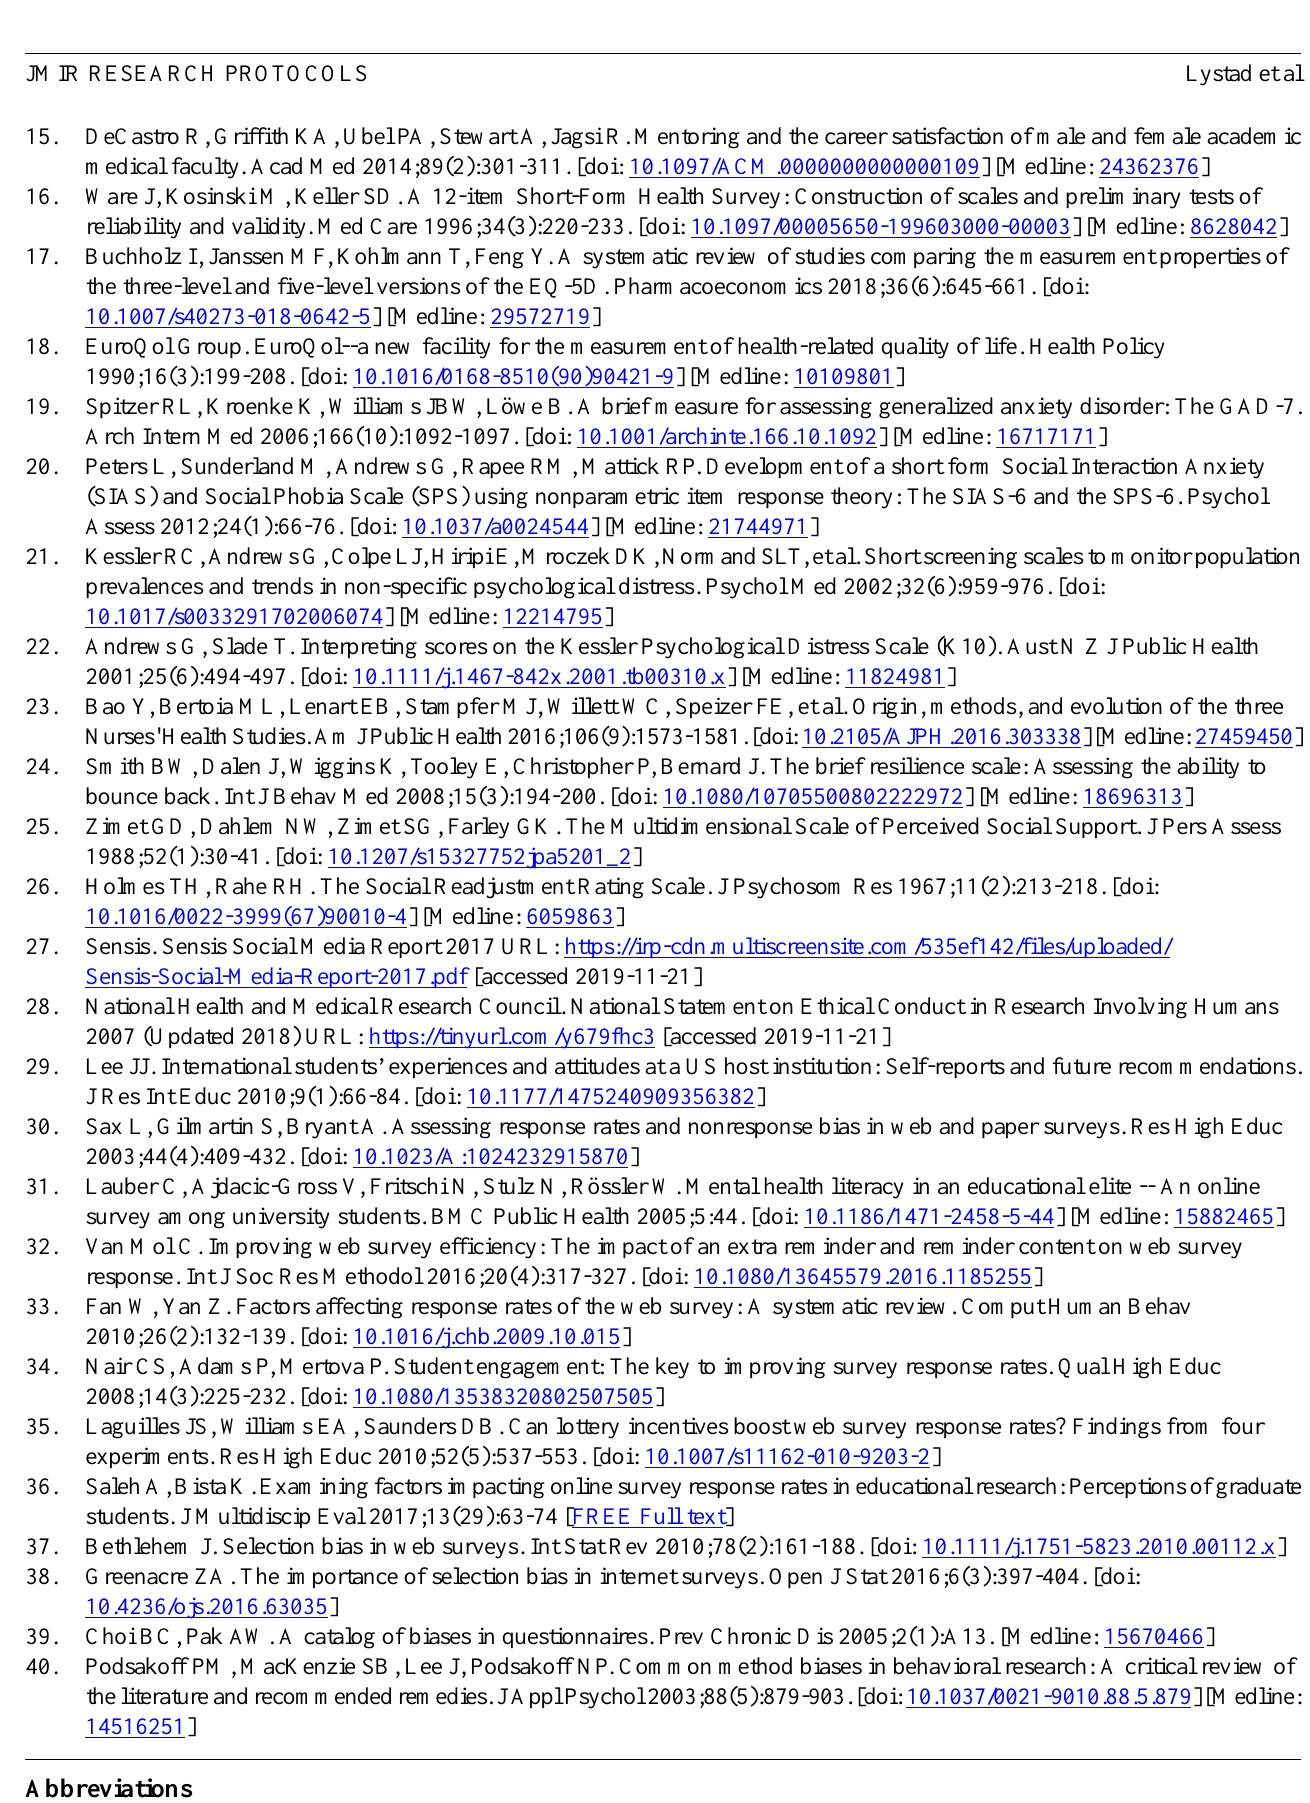
Abbreviations ACTRN: Australian New Zealand Clinical Trials Registry BRS: Brief Resilience